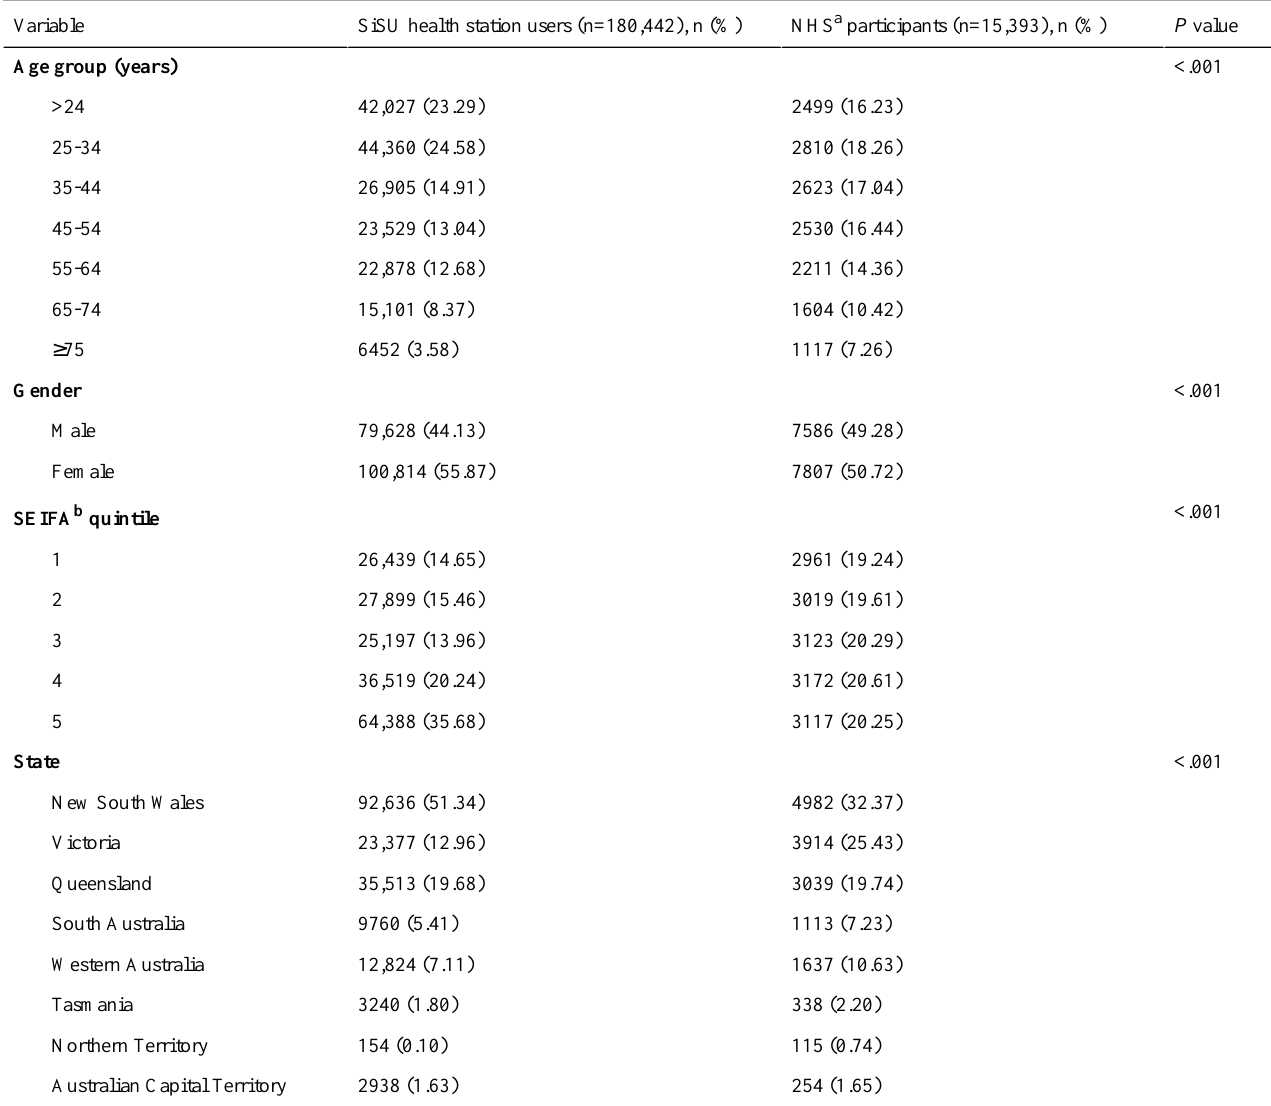
Table 1. Comparison of the demographic characteristics of SiSU health station users and National Health Survey